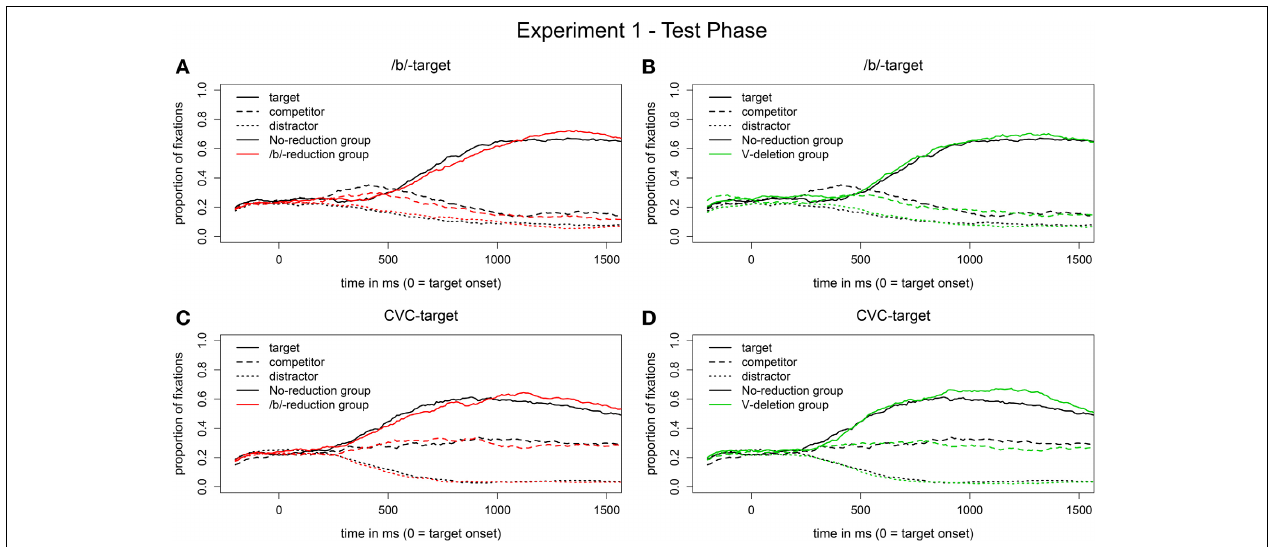
FIGURE 4 | Proportion of fixations in the segmental reduction condition [reduced /b/-words in auditory input, visual /b/-targets on screen; (A,B)] and in the syllabic reduction condition [vowel-deleted words in auditory input, visual CVC-targets on screen; (C,D)] in the test phase of Experiment